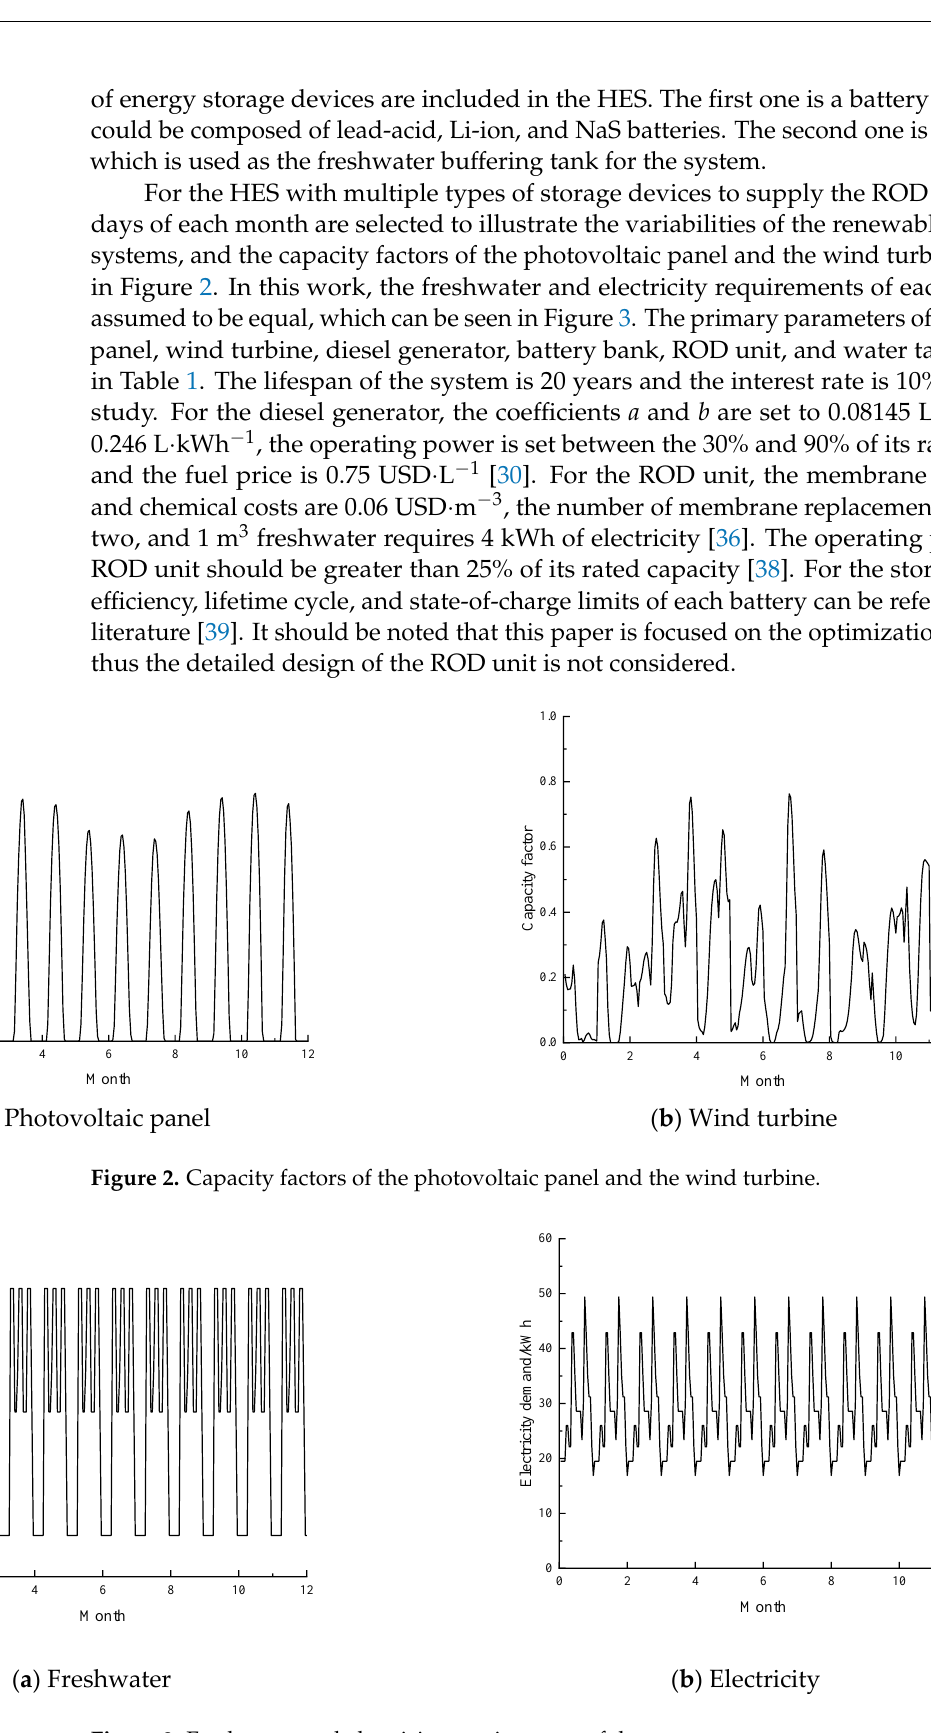
Figure 3. Freshwater and electricity requirements of the system. Table 1. Parameters of the system